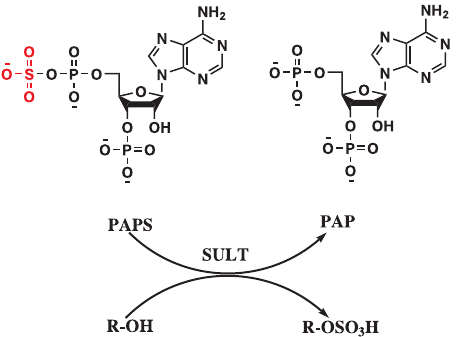
Figure 1. Schematic of the Reaction Catalyzed by